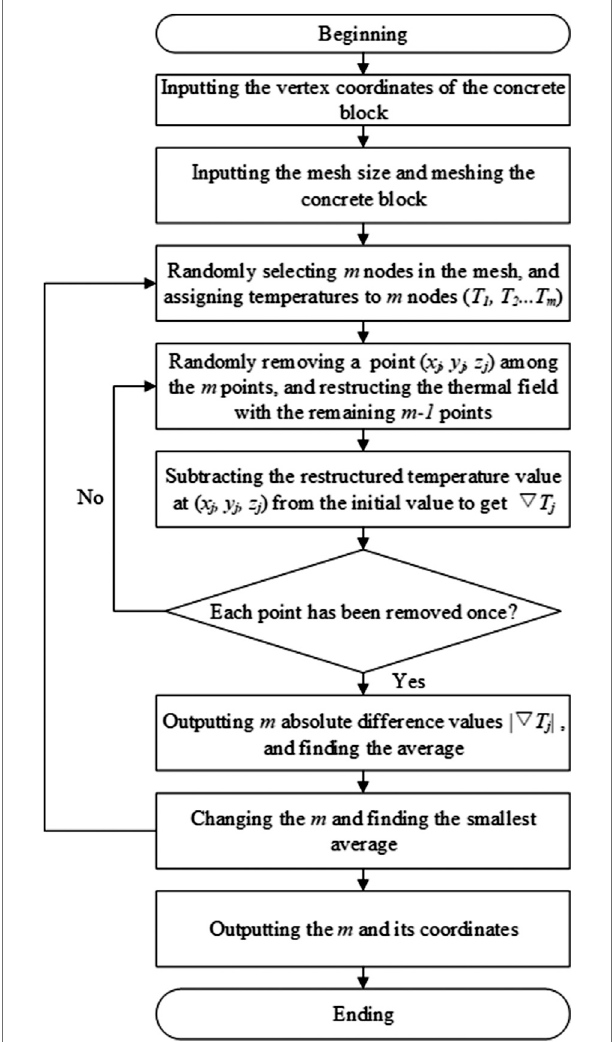
FIGURE 1 | The fl ow chart of the PMTS.